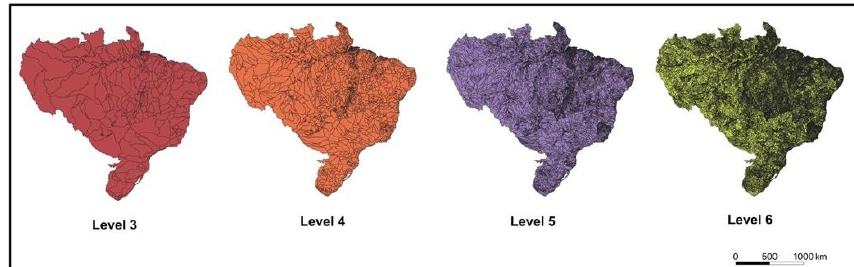
Figure 6 . Brazilian hydrographic basins (Ottobacias) in cross-border view. Figure 6. Brazilian hydrographic basins (Ottobacias) in cross-border